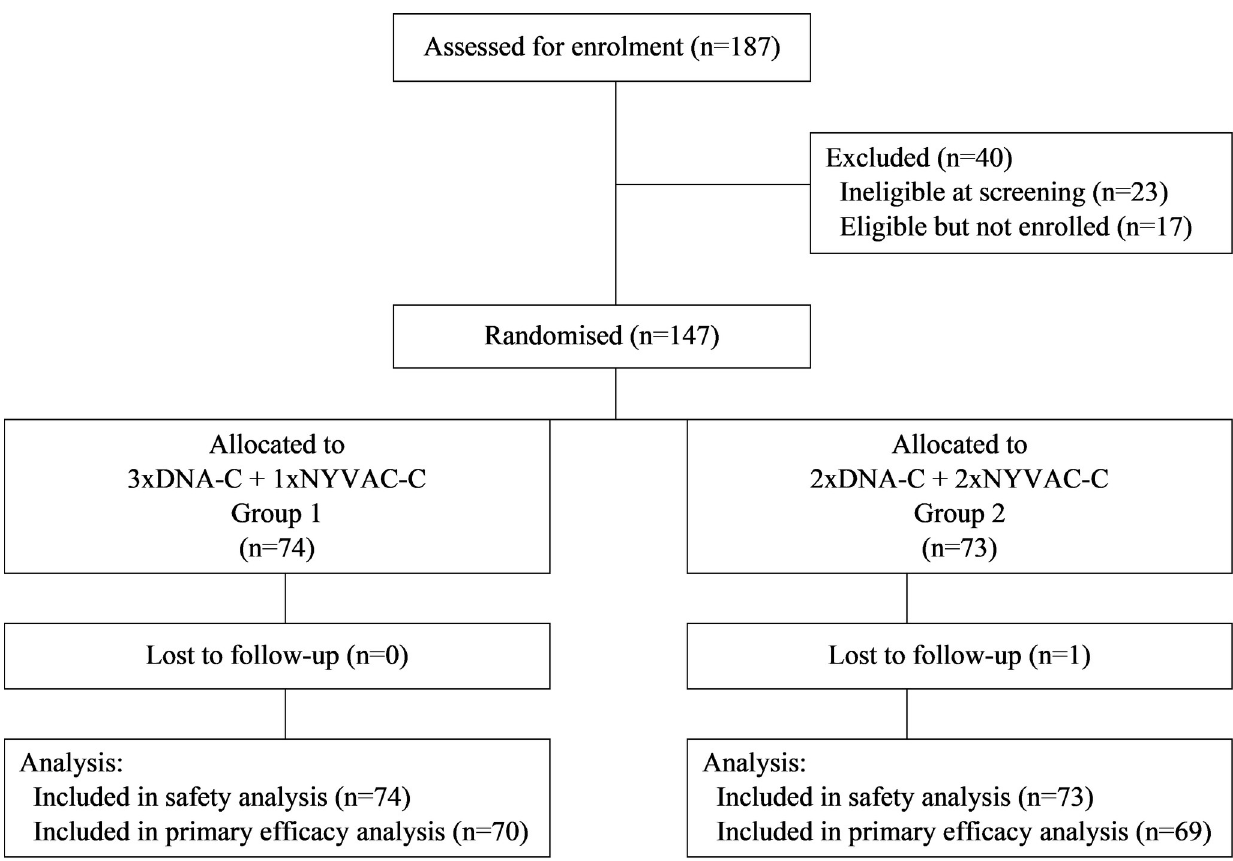
Fig 1. Consort flow diagram, EV03/ANRS VAC20 Phase I/II